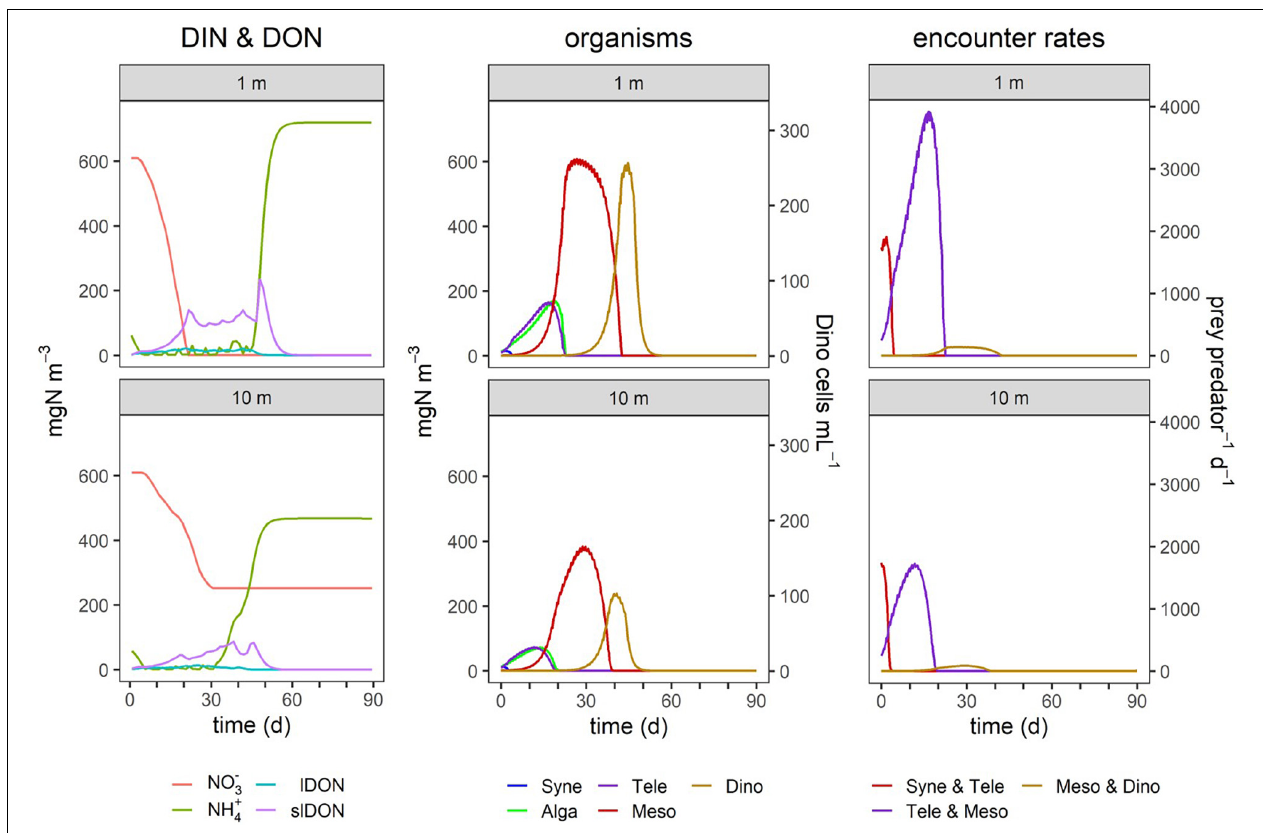
FIGURE 8 | TMD dynamics in simulated systems of different mixed layer depths (MLD). Simulations were run with an MLD of 10 m or 1 m, the latter simulating a thin layer; Dinophysis is often found in thin layers in stratified water columns where it is much easier to capture its fast prey Mesodinium due to much higher encounter rates. Encounter rates are of the three mixoplankton ( Teleaulax , Mesodinium , and Dinophysis ) with their respective prey, as shown in Figure 2 . Other details as given in Table 4 and in the legend of Figure 4